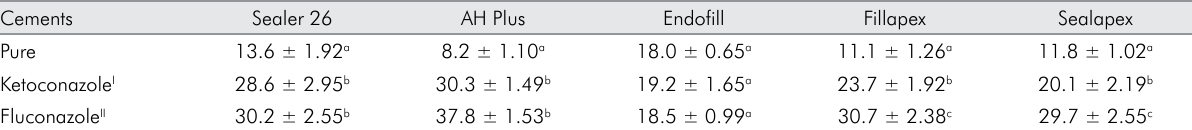
Table 3. Mean and standard deviation of inhibition halos (mm) of the sensitivity of C. albicans to sealers, pure and following addition of antifungals in 48